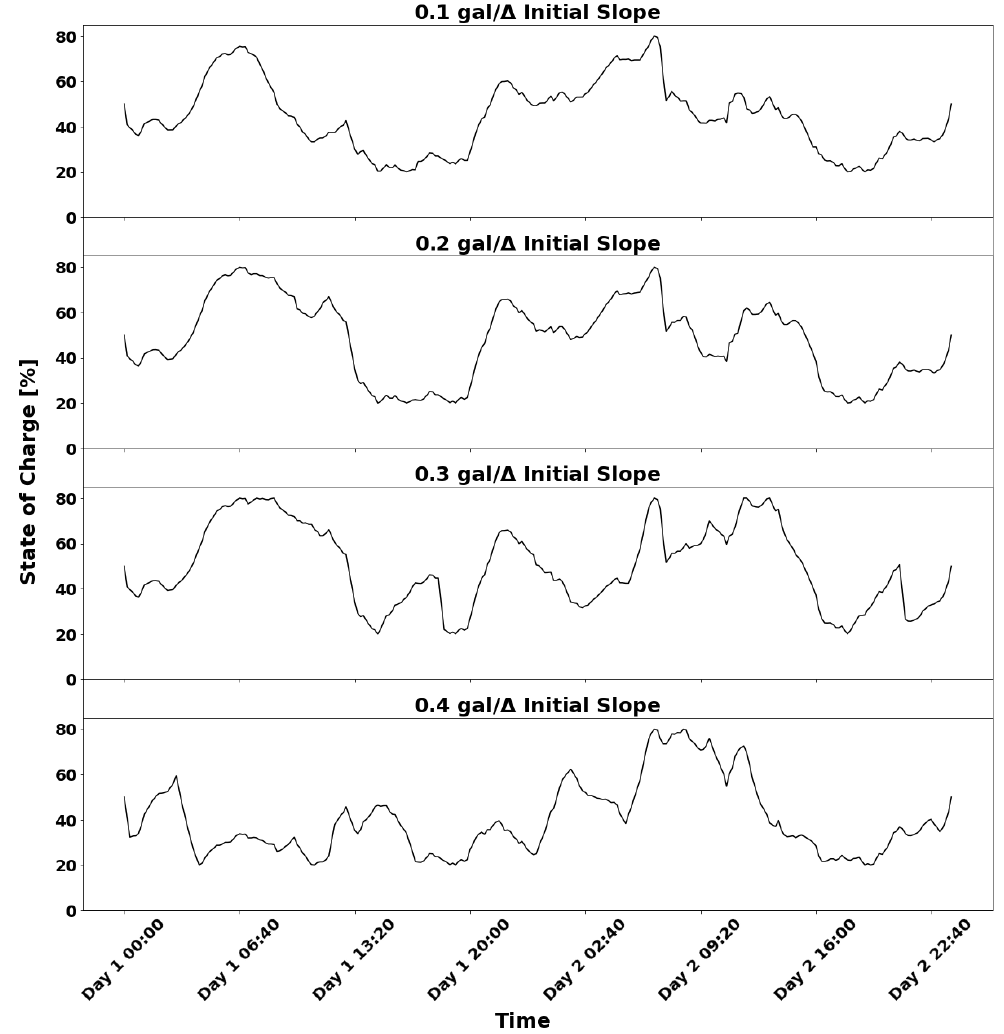
Figure 10. Battery SOC for the instances shown in Figure 9. Table 2. Optimal fuel consumption and power output with various piecewise linear penalties for the summer demand